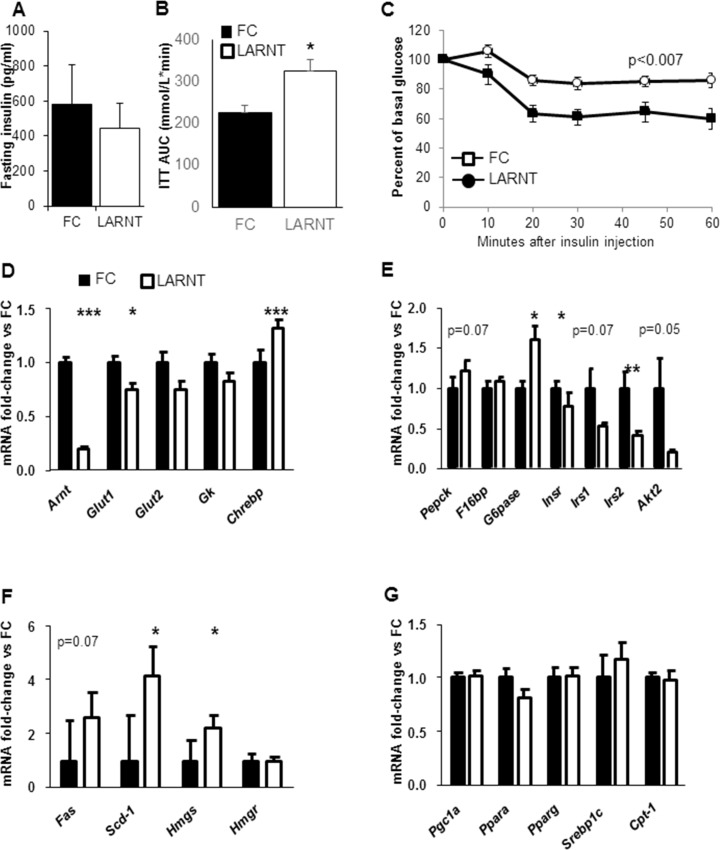
Hepatocyte ARNT deletion alters hepatic glucose production and gene expression.Results for floxed controls (FC) are shown in black and LARNT mice in white (bars or circles). (A) Fasting serum insulin levels in FC and LARNT mice at 20 weeks (median and 95% CI). (B) Insulin tolerance tests (ITT) Area Under the Curve (AUC) at 13 weeks. (C) ITT curves; levels are expressed as % of baseline glucose level at 0 minutes. (D-G) Fold changes in LARNT versus FC mice. * = p<0.05 ** = p<0.01, *** = p<0.001, N = 5–6.